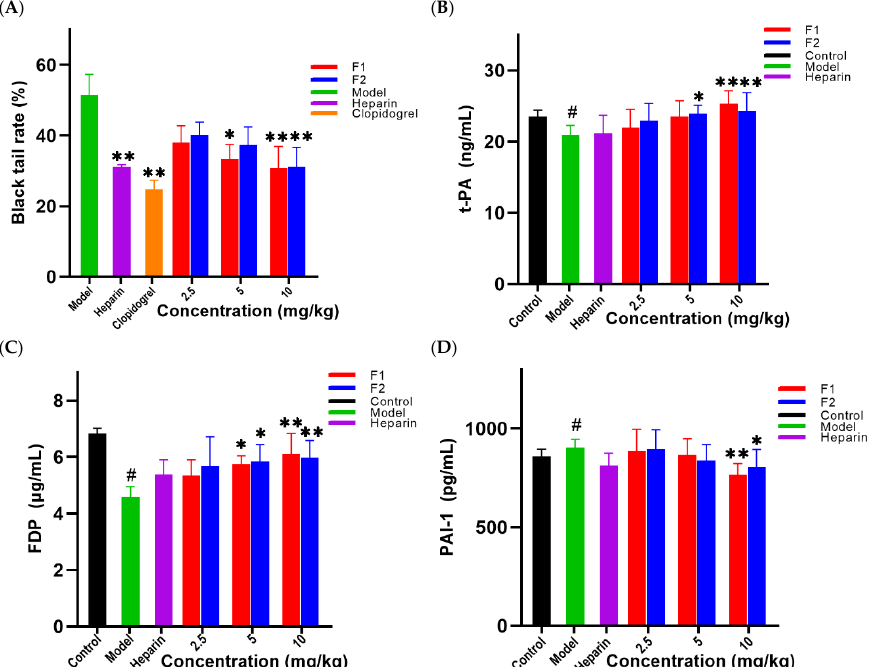
Figure 10. At the end of 48 h ( A ) in different treatment groups, the thrombosis rate was calculated (the ratio of the tail length with thrombus to the whole tail length), the content of t-PA, PAI-1 and FDP ( B – D ) in the plasma of mice in different treatment groups (# p < 0.05 vs. control group;* p < 0.05, ** p < 0.01 vs. Model Group).